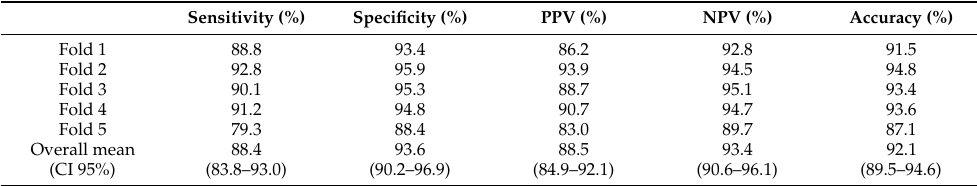
Table 1. Five-fold cross validation during the training phase.